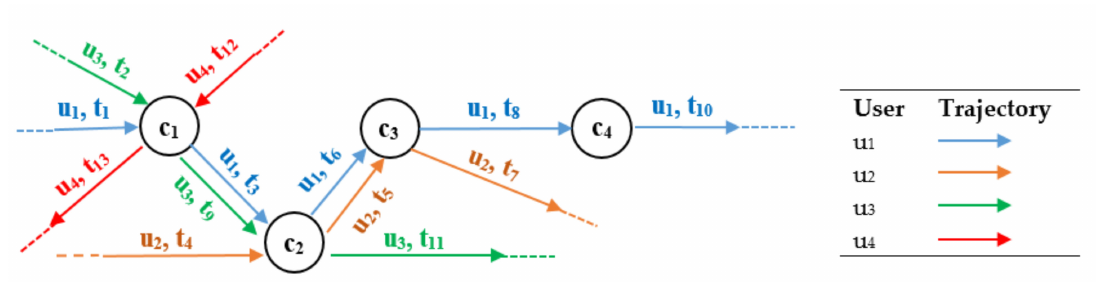
Figure 2. Representation of semantic movement trajectories of four users in the indoor